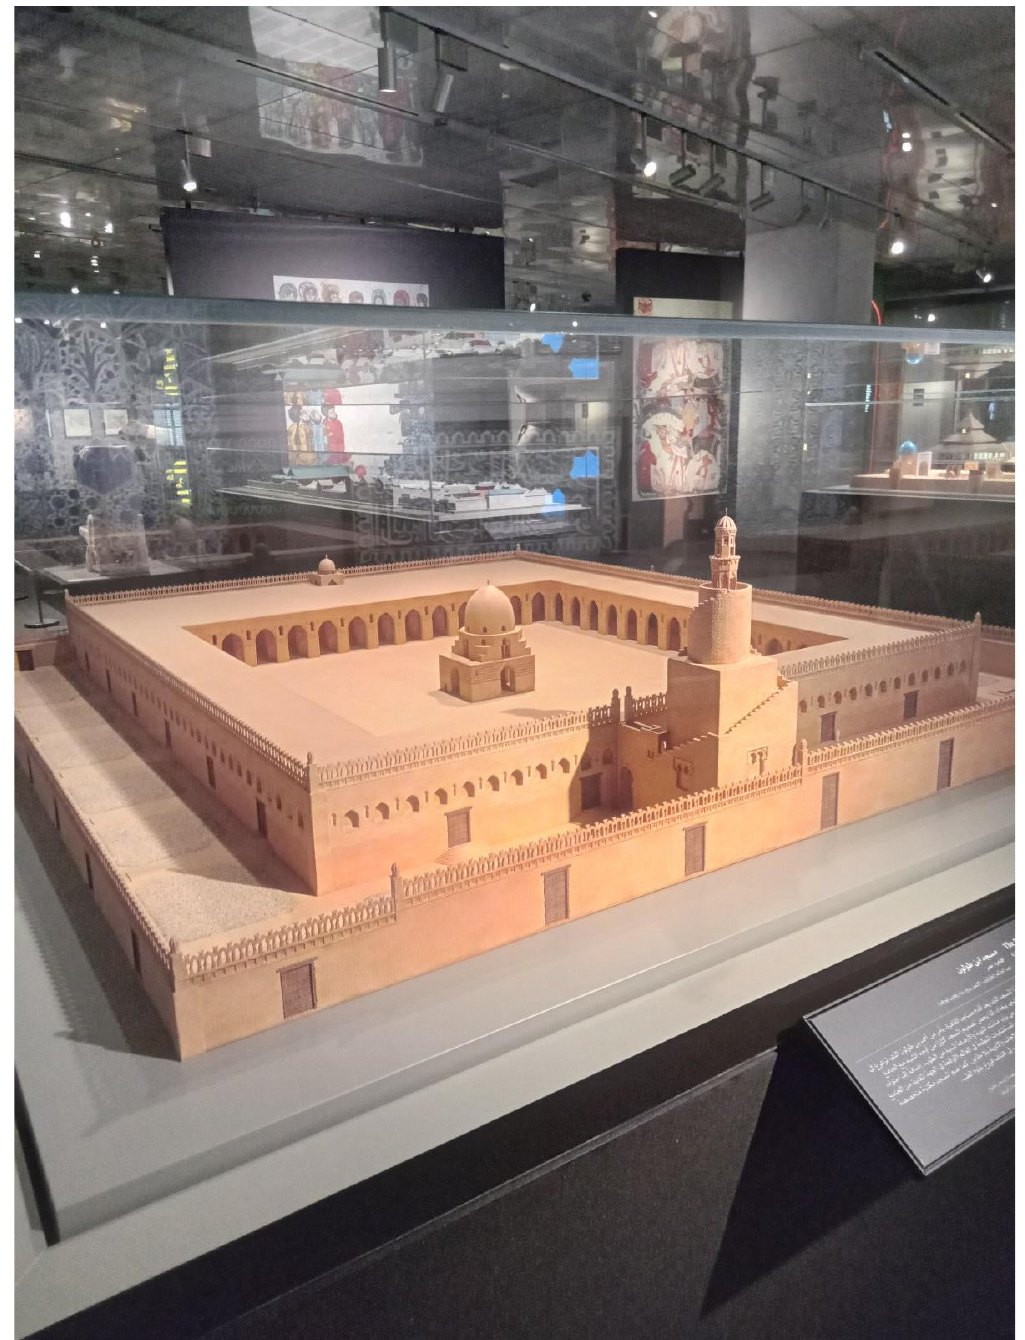
Figure 20. The collection of Islamic art in the King Abdulaziz Center for World Culture (Ithra), Dhahran, Saudi Arabia. Model of the Mosque of Ibn Tulun, Cairo, Egypt. Photo of the author.